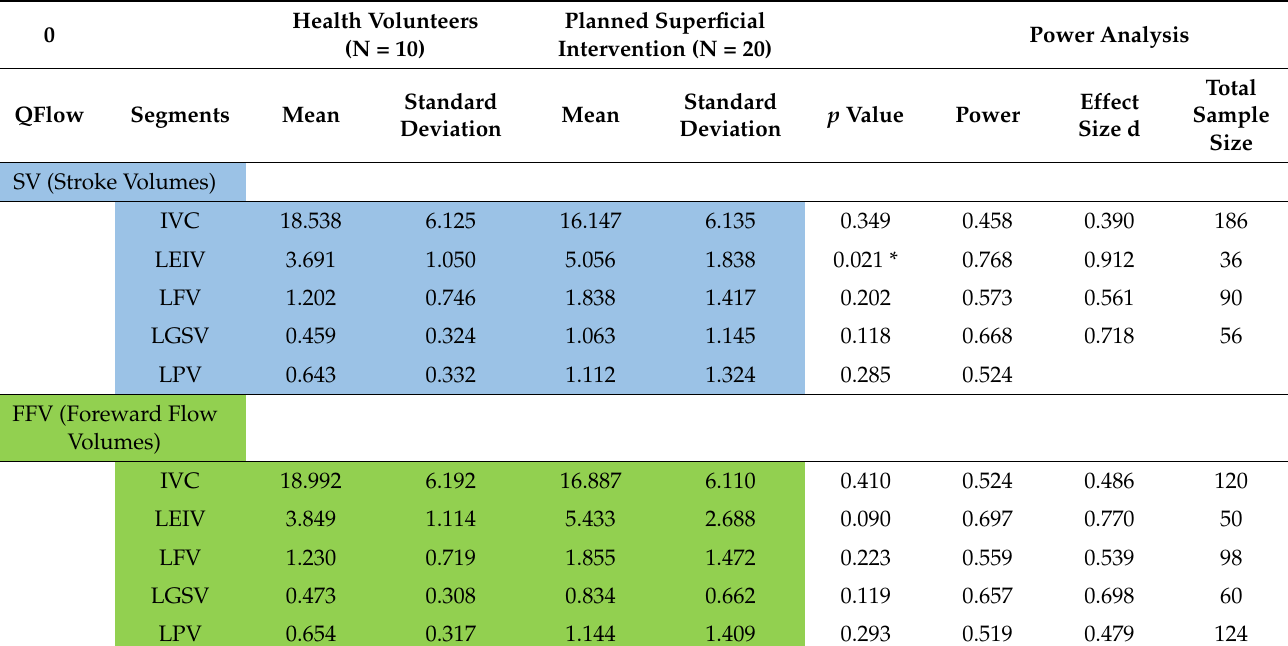
3.2. Comparison of TRANCE-MRI Hemodynamic Parameters between the Morbid Limbs and Healthy Volunteers QFlow analysis performed through TRANCE-MRI examined the SV (mL), forward flow volume (FFV, mL), MF (mL), SD (cm), and MV (cm) in the vena cava, EIVs, FVs, PVs, and GSVs in the 30 patients and healthy controls. To decrease bias in the QFlow analysis, we analyzed the same side of the legs of controls as that of patients who received interventions. Table 4 shows the findings of the QFlow comparison of 10 patients who received interventions in their left leg with the left legs of 20 controls. SVs were higher in the EIVs ( p = 0.021) in the left-leg-intervention group. The MF was higher in the EIV ( p = 0.012) and tended to increase in the GSV ( p = 0.087) in the left-leg-intervention group. SD was longer in EIV segments. Table 4. Comparison of the QFlow parameters between the left legs of health controls and the left legs planning for truncal